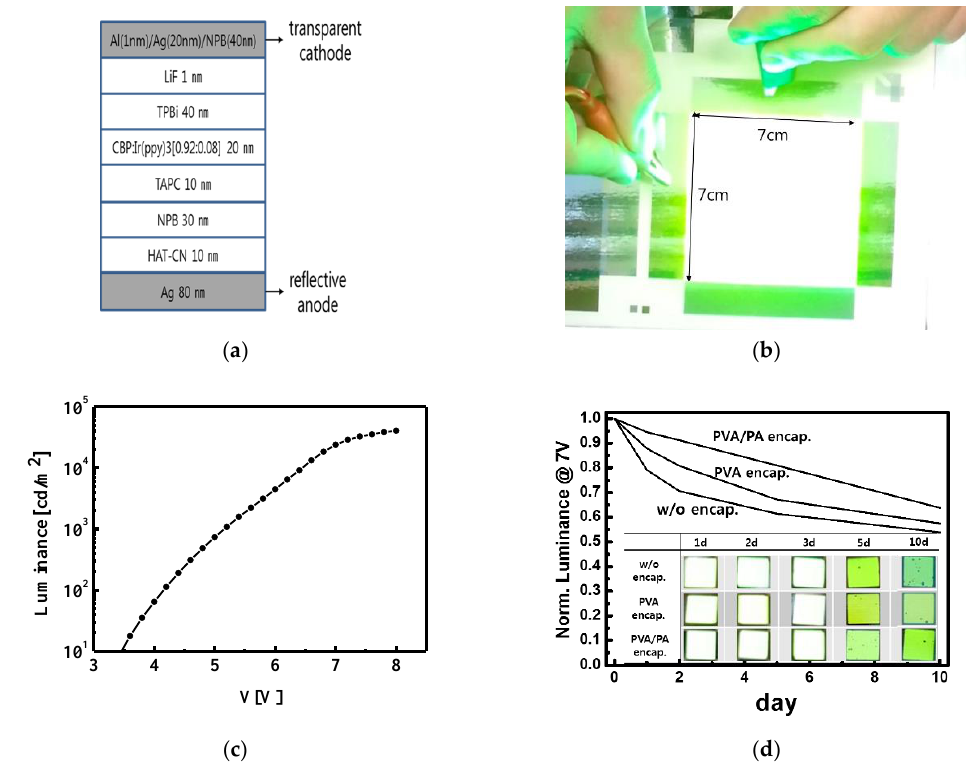
Figure 6. ( a ) The structure of the phosphorescent OLED, ( b ) an OLED light fabricated on a PET fabric substrate with an area of 7 cm × 7 cm, ( c ) the luminance characteristics of the top emitting phosphorescent OLED fabricated on the PET fabric substrate, and ( d ) the degradation of the OLED luminance with and without the PVA/PA encapsulation.